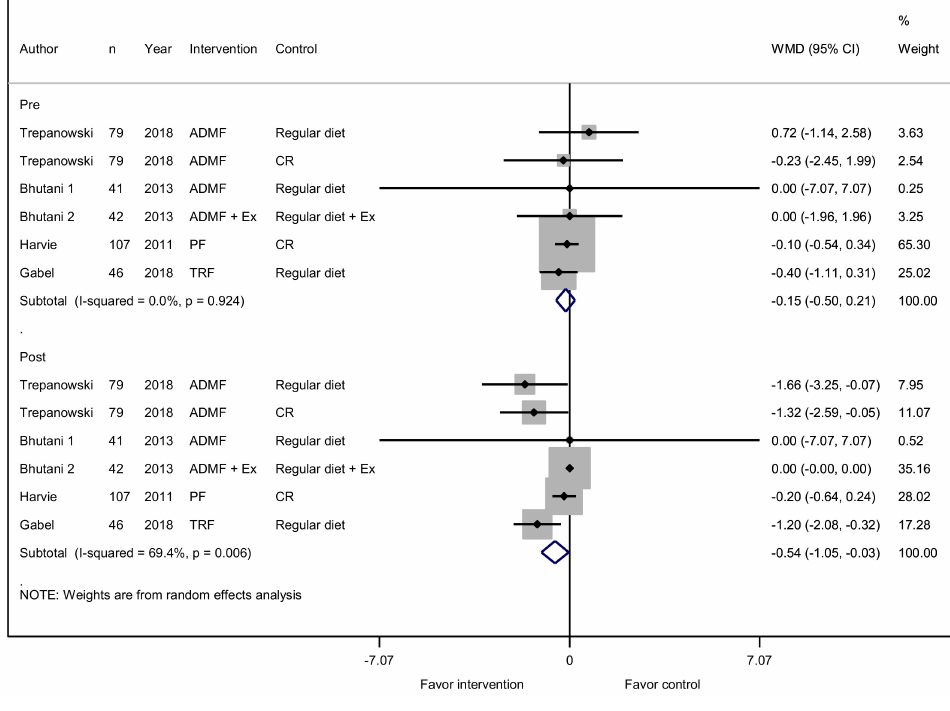
Figure 4. E ff ect of IF versus non-fasting control on homeostatic model assessment of insulin resistance (HOMA-IR) (changes from baseline) in adults without chronic metabolic